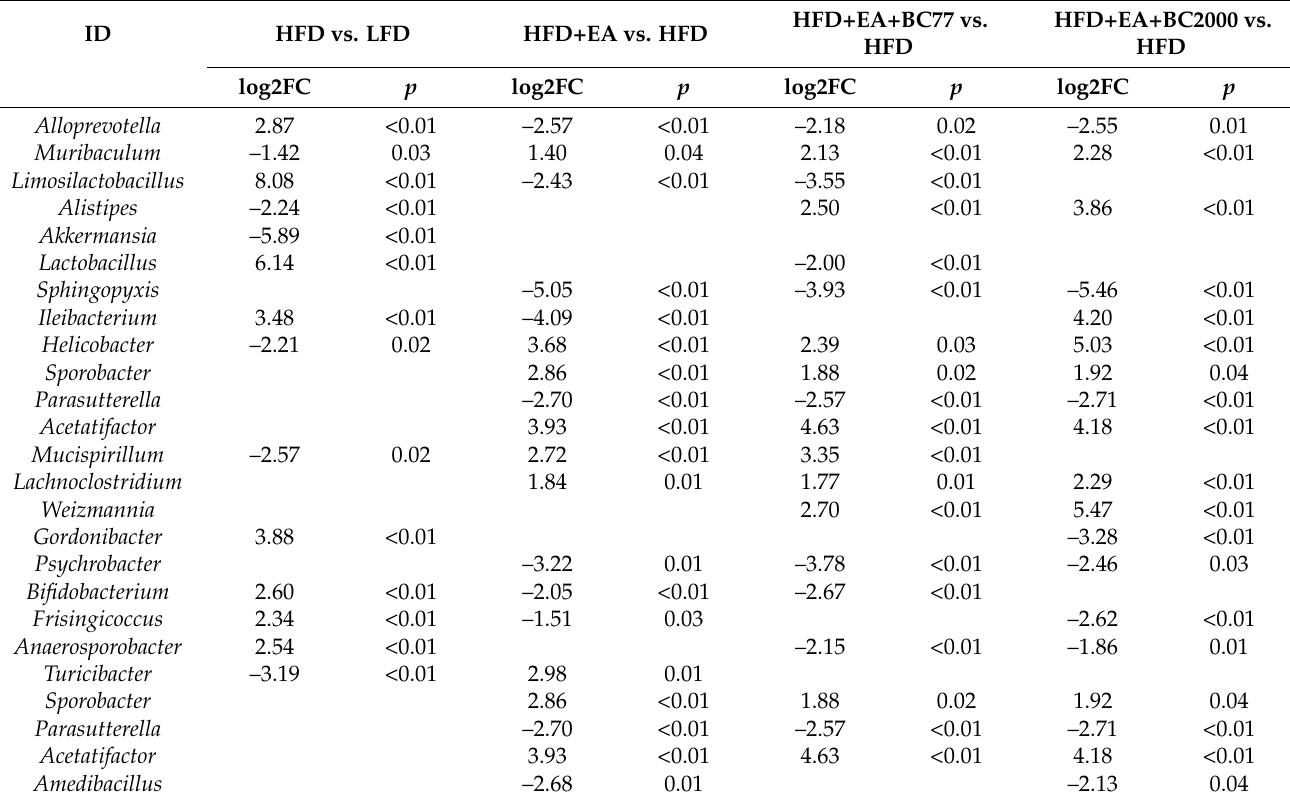
Table 2. Mouse cecum bacteria significantly affected by